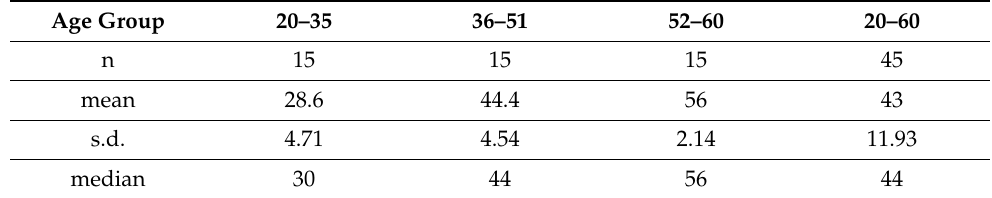
Table 1. Statistical description of participant age